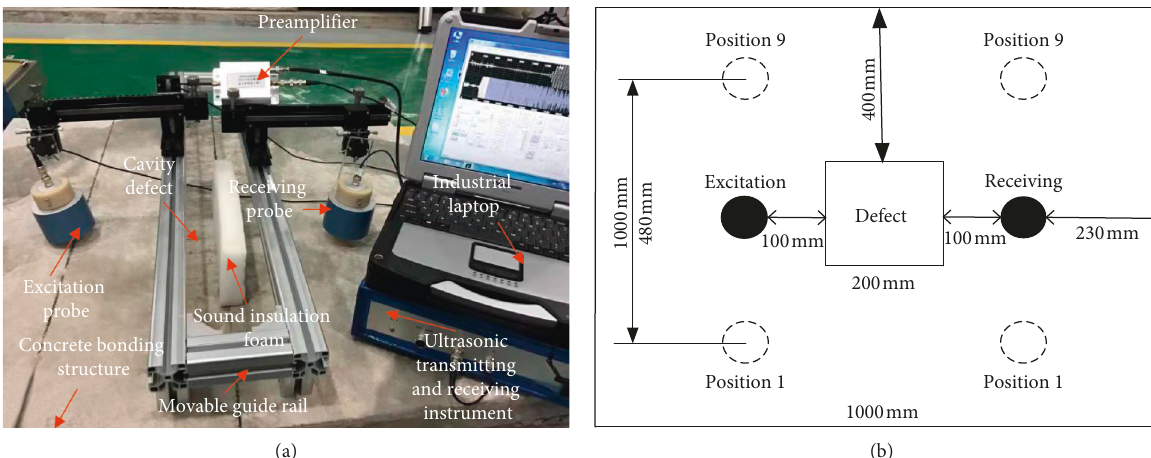
Figure 10: (a) Experimental system and (b) schematic of the signal acquisition mode.